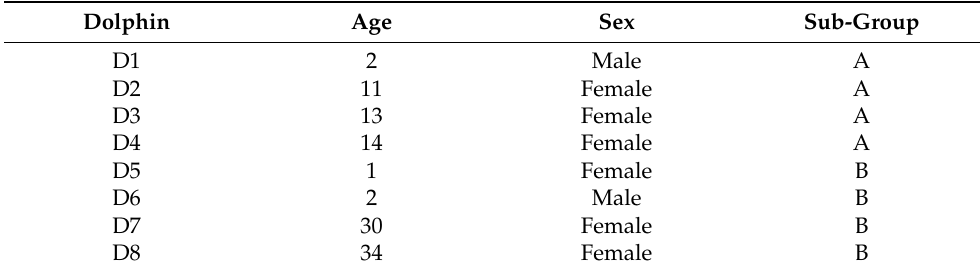
Table 1. Participant demographic